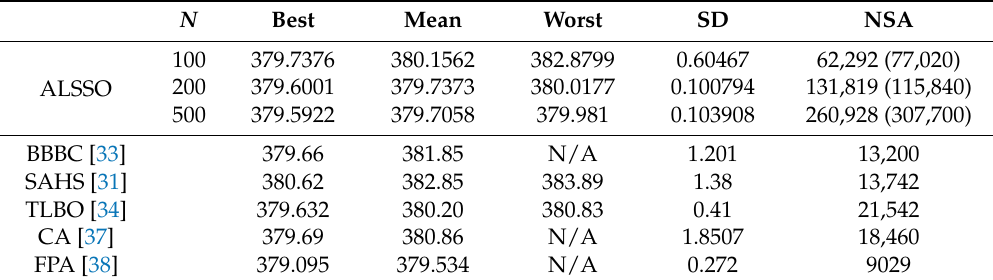
Table 9. Comparison of statistical performance in the 72-bar truss problem.